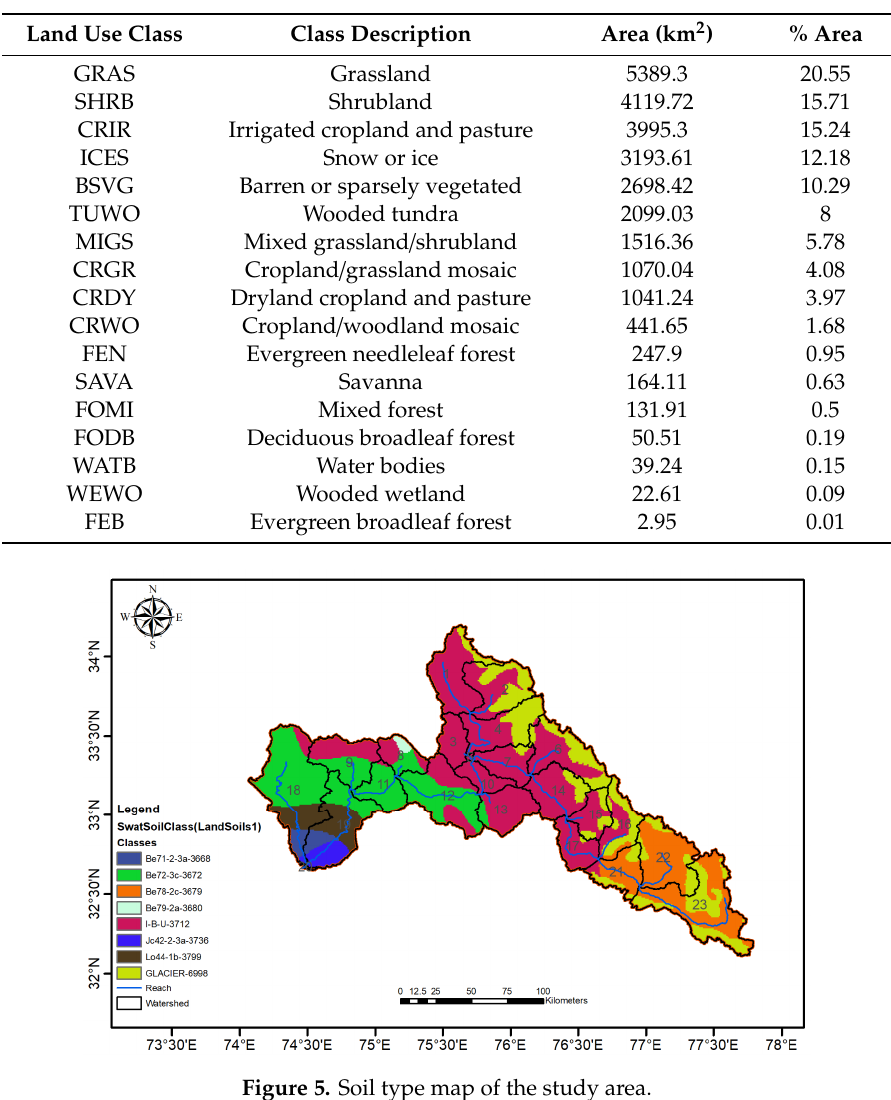
Figure 4. Land use map of the study area. Table 1. Land use classification in the study area.